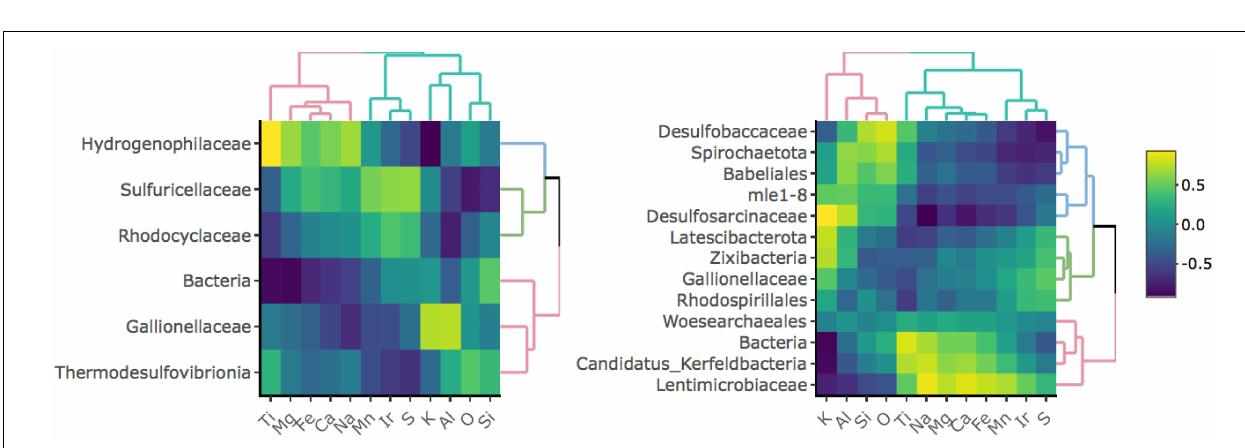
Frontiers in Microbiology |